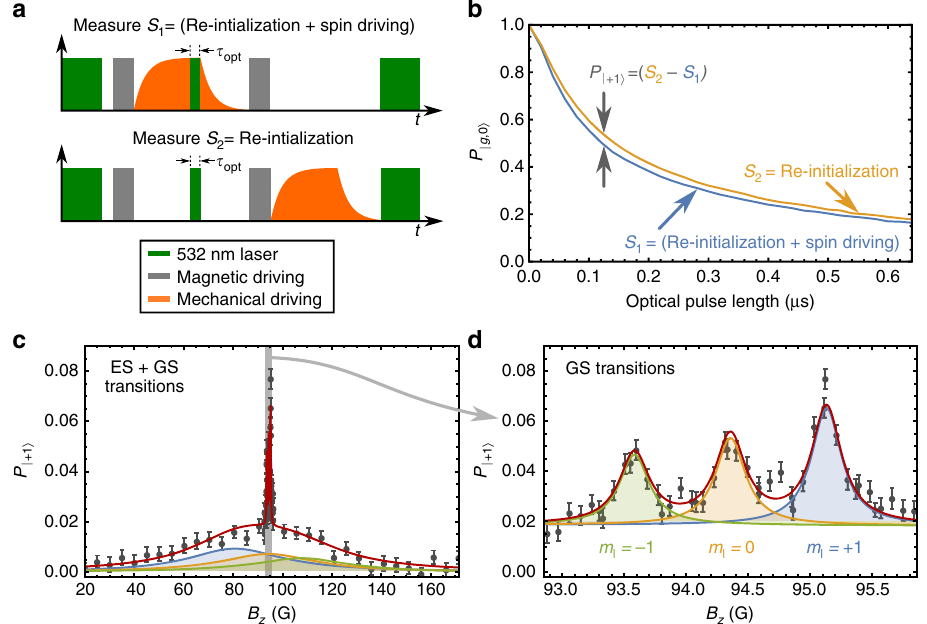
Figure 2 | Spin–strain spectroscopy. ( a ) Pulse sequences used to measure excited state (ES) spin driving. ( b ) Population in g ; 0 j i at the end of the pulse sequences in a plotted against t opt . ( c ) Spectrum of the spin population driven mechanically into þ 1 j i by the ES and ground state (GS) spin–strain interactions. The red curve is a least squares fit to the sum of six Lorentzians. ( d ) Zoomed in view of the GS spin transitions in c . The data in c , d were measured on one device with an NV centre ensemble, and error bars are from the s.d. in photon counting.